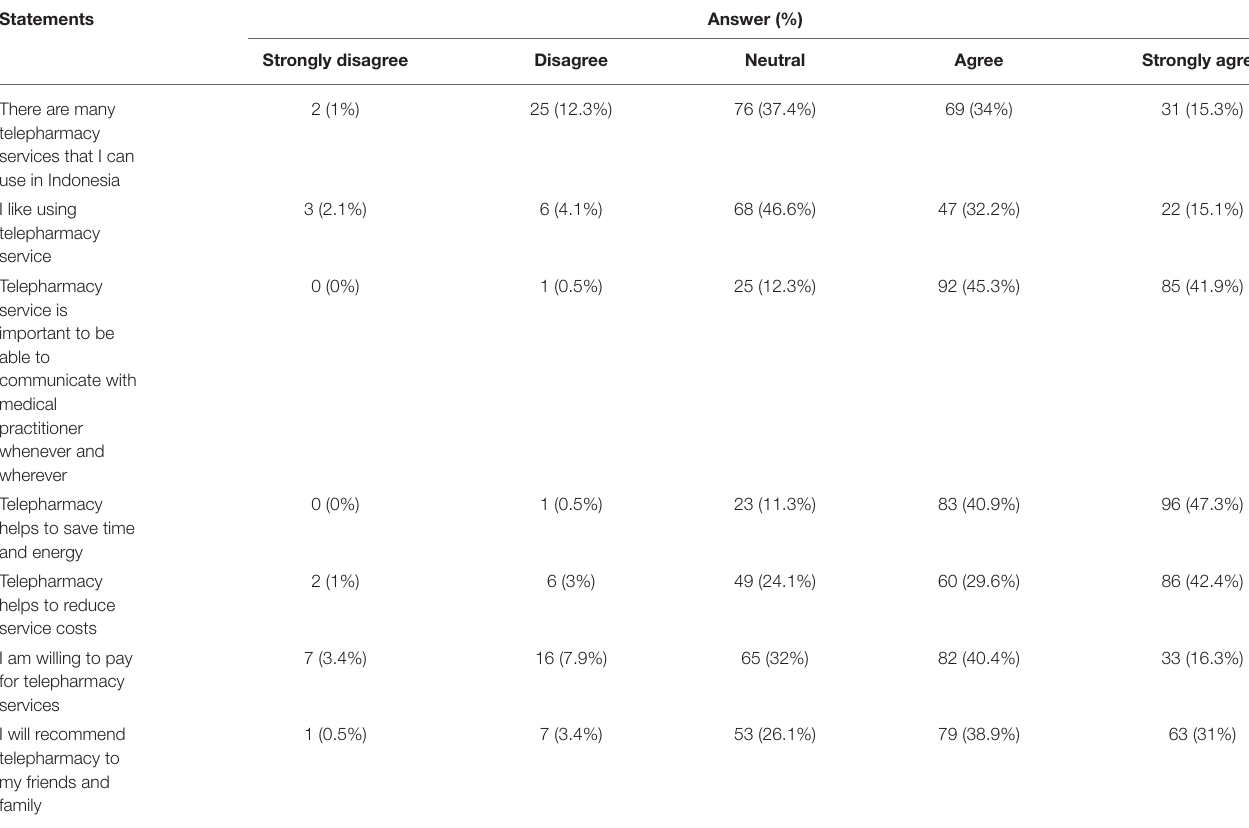
TABLE 3 | Perception of telepharmacy